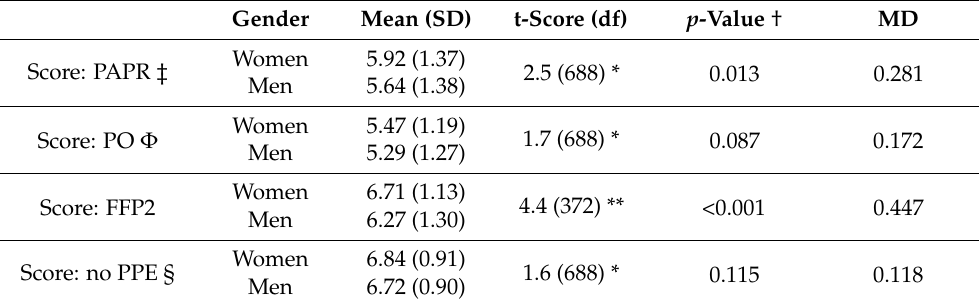
Table 3. Success scores of the participants according to gender and type of Personal protection equipment (maximum 8 points) (mean [standard deviation], t-score [degrees of freedom], p -value and mean difference) ( n = 690). Gender p -Value